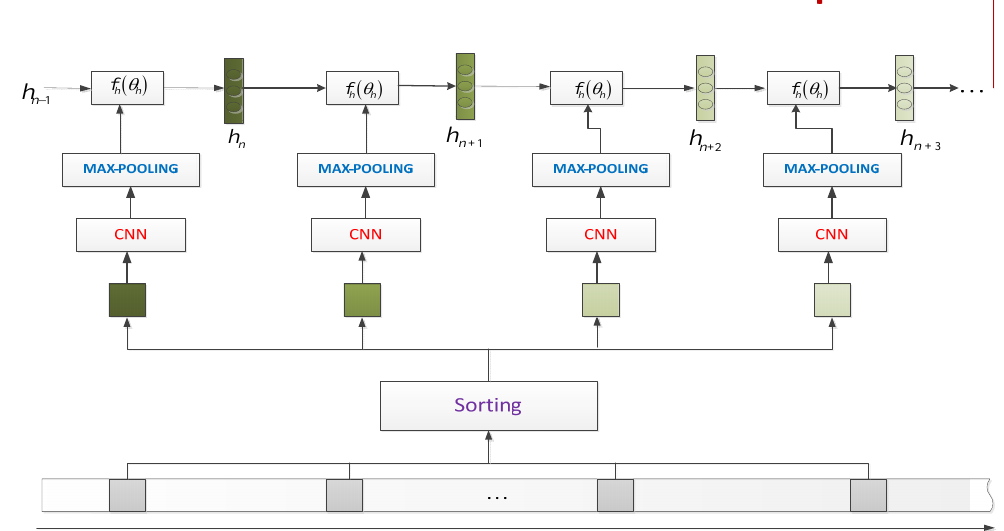
Figure 3. Model CNN_LSTM_AGG architecture.